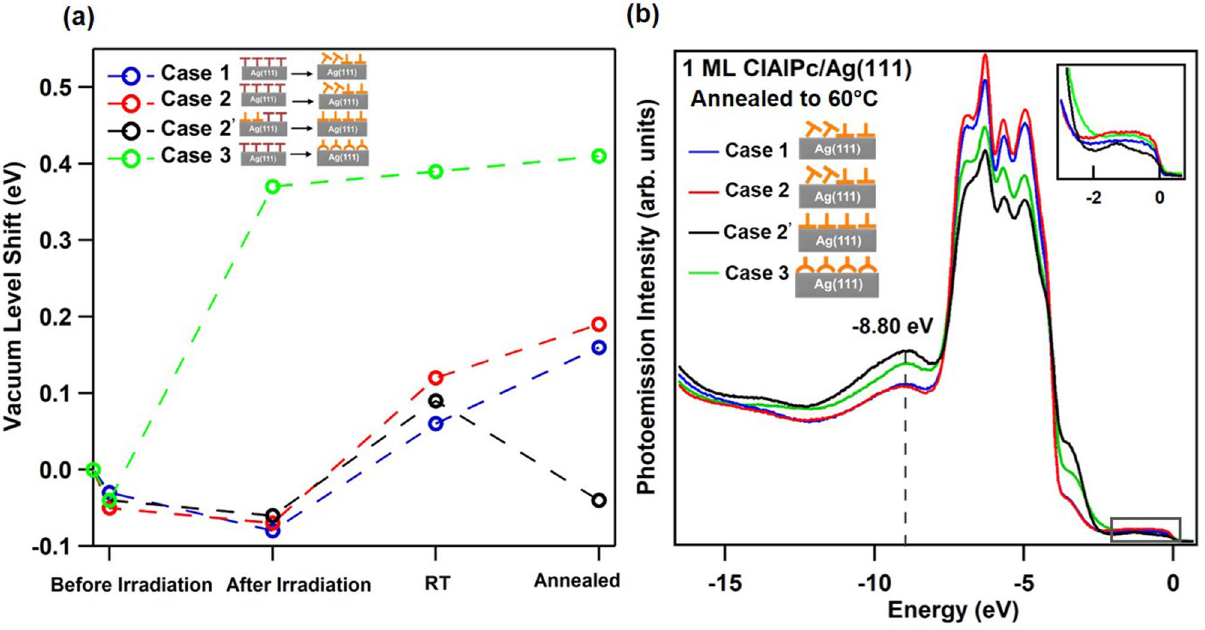
Figure 6. ( a ) VL shifts at the four stages of before-irradiation, after-irradiation, post-annealed-to-RT, and post-annealed-to-60 °C for the four different cases. The zero value of VL shift is with respect to Ag(111). The graphic annotation indicates the transition from the initial stage of before-irradiation to the final stage of post- annealed-to-60 °C. ( b ) Photoemission spectra at the stage of post-annealed-to-60 °C for the four different cases. The black dashed line indicates the energy position of the Cl-up molecular-energy-state peak. The inset magnify the spectra in the energy range near Fermi groups to either peak (A) or (B) are compatible for the typical flat-on Cl-up configuration. For the special upheld Cl-up configuration, as represented by case 3, the charge-transfer channel from Ag(111) via inner ligand ring, as indicated by the orange arrows in Fig. 1b, should substantially reduce, so peaks (A) and (B) for case 3 are lower than those of the typical flat-on Cl-up configuration as represented by case 2’. A further confirmation can be seen from the inset in Fig. 6b where the HOMO peak at about − 1.25 eV is only obvious for case 2’; this peak is mainly contributed from inner ligand ring according to the partial DOS shown in Fig. 3c.